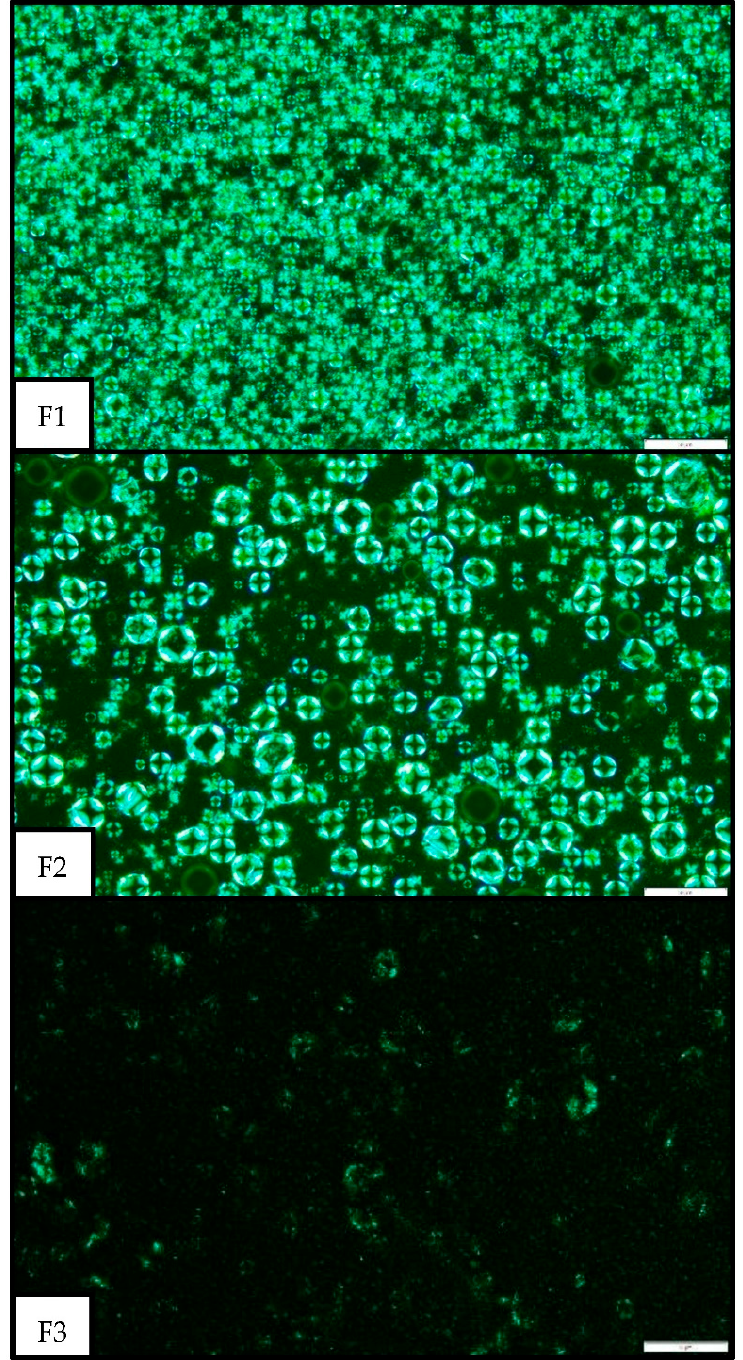
Figure 4. Polarized light microscopy photomicrographs (400× magnification ) of the developed products (without and with germinated brown rice extract F1 and F2, respectively) and a liquid crystal cream from a counter brand (F3).